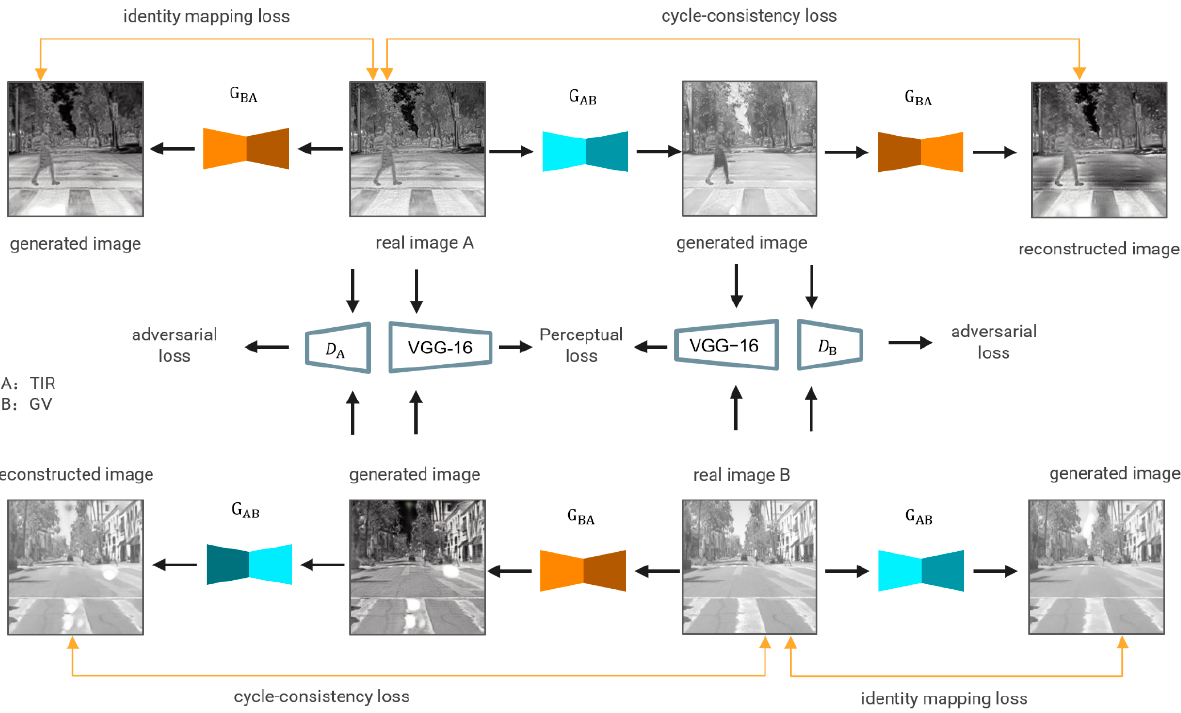
Figure 2. The schematic diagram of GMA-CycleGAN.